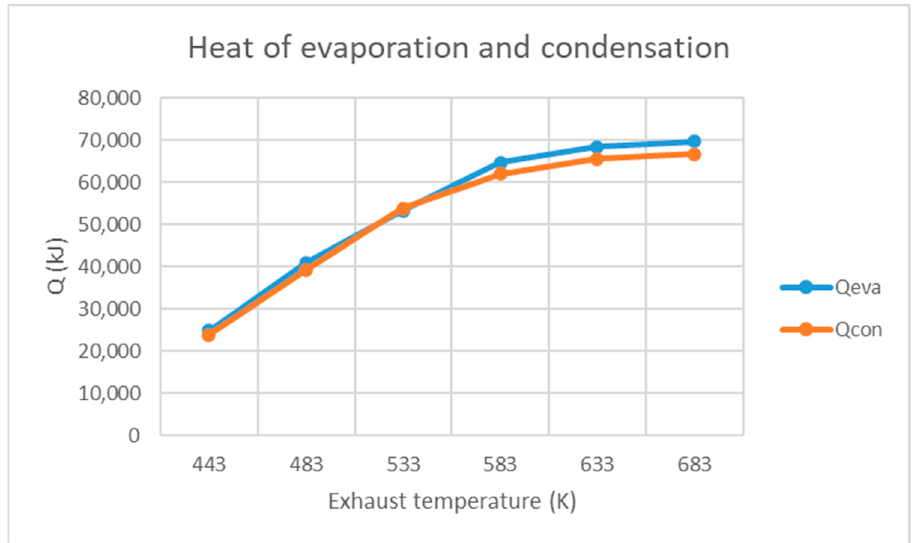
Figure 7. Evaporating and condensing heat vs. exhaust temperature.